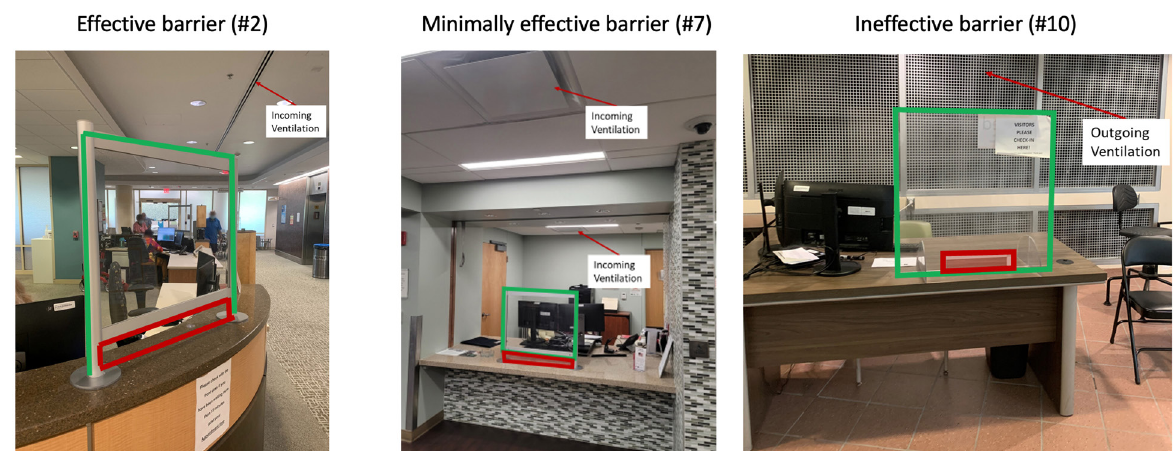
Figure 3. Pictures of 3 of the barriers tested. The red rectangles outline the location of openings of the barriers and the green lines outline the outer borders of the barriers. Barrier 2 is width 30” x height 28” with an opening of width 30” x height 4”. Barriers 7 and 10 are width 30” x height 30” with an opening of width 12” x height